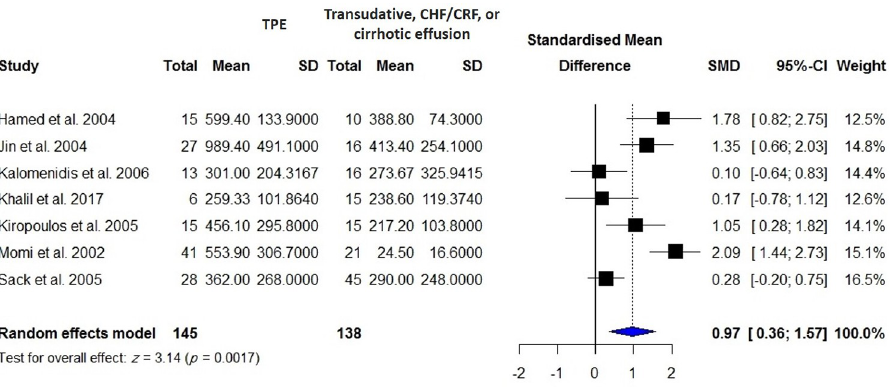
Fig 3. Meta-analysis of blood VEGF levels in patients with TPE vs. patients with transudative, CHF/CRF, or cirrhotic